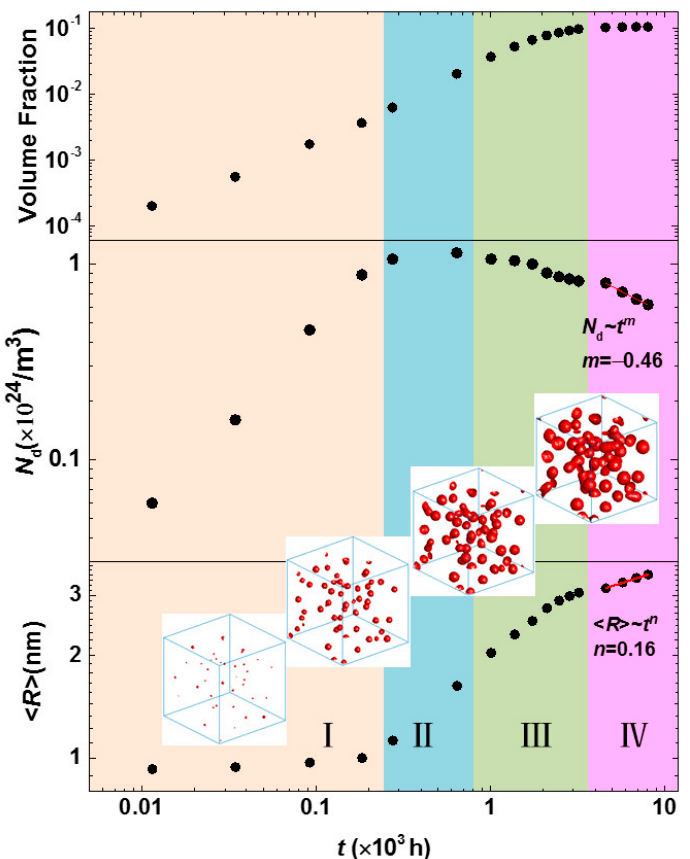
Figure 3. The temporal evolution of the volume fraction, particle number density and the average particle radius of the Cr-enriched α′ phase in the Fe-25 at % Cr alloy aged at 750 K. The inserted morphology evolution is for 3D α′ particles from initial growth to coarsening.